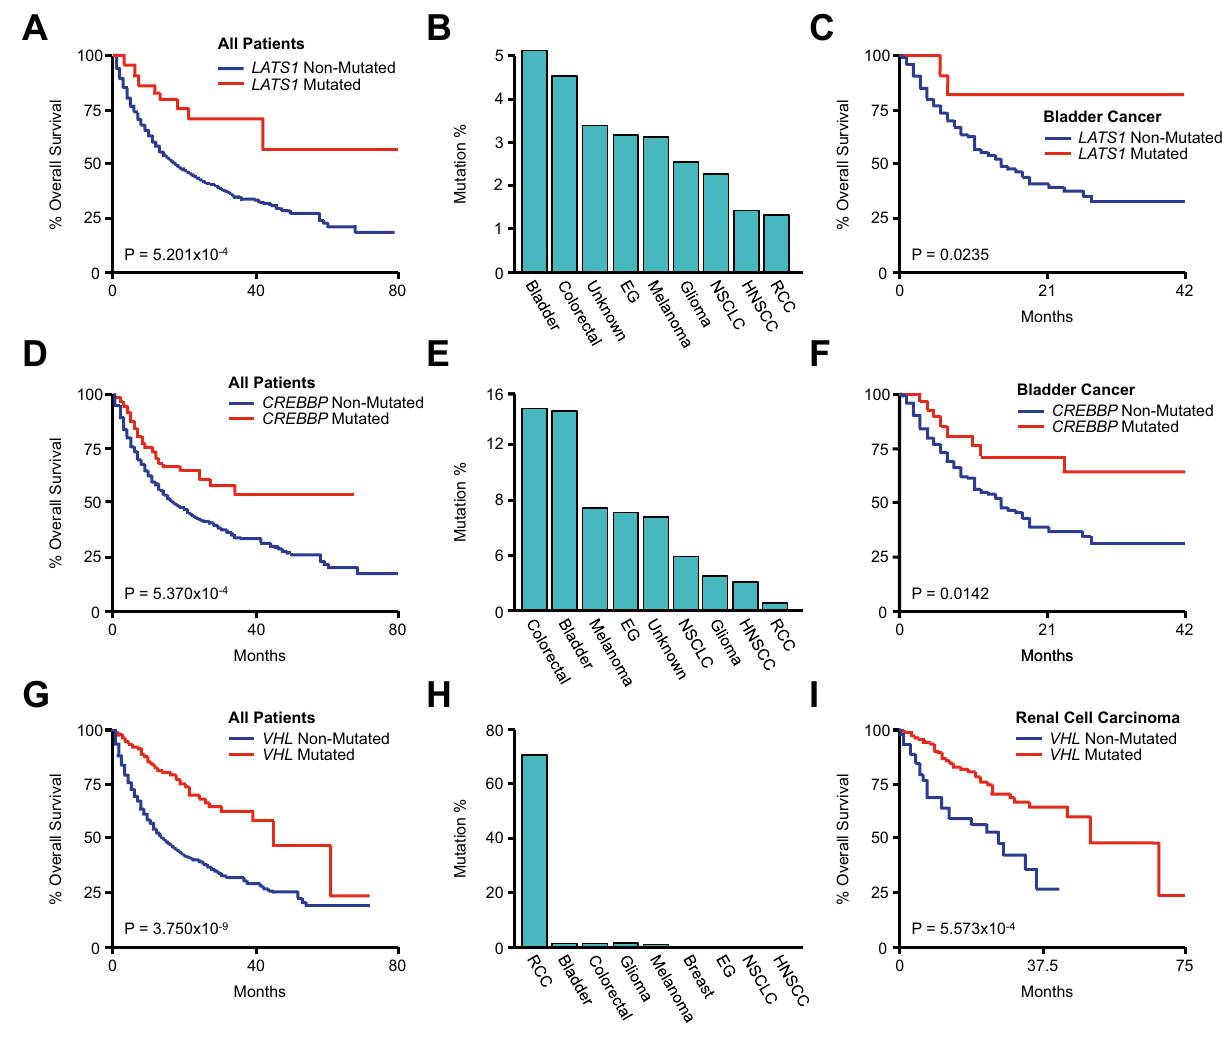
Figure 8. LATS1, CREBBP, and VHL mutations are associated with improved survival in urologic malignancies. ( A ) Kaplan Meier plot showing overall survival for the pan-cancer cohort (N = 1661) arranged by LATS1 mutation status (48 LATS1 -mutated and 1613 LATS1 -non-mutated patients). ( B ) The percent of LATS1 -mutated patients arranged by tumor type. ( C ) Kaplan Meier plot showing overall survival for the bladder cancer cohort arranged by LATS1 mutation status (N = 215, 11 LATS1 -mutated and 204 LATS1 -non-mutated patients). ( D ) Kaplan Meier plot showing overall survival for the combined pan-cancer cohort method arranged by CREBBP mutation status (108 CREBBP -mutated and 1553 CREBBP -non-mutated patients). ( E ) The percent of CREBBP - mutated patients arranged by tumor type. ( F ) Kaplan Meier plot showing overall survival for the bladder cancer cohort arranged by CREBBP mutation status (31 CREBBP -mutated and 184 CREBBP -non-mutated patients). ( G ) Kaplan Meier plot showing overall survival for the pan-cancer cohort arranged by VHL mutation status (111 VHL -mutated and 1550 VHL -non-mutated patients). ( H ) The percent of VHL -mutated patients arranged by tumor type. ( I ) Kaplan Meier plot showing overall survival for the renal cell carcinoma cohort arranged by VHL mutation status (N = 151, 106 VHL -mutated and 45 VHL -non-mutated